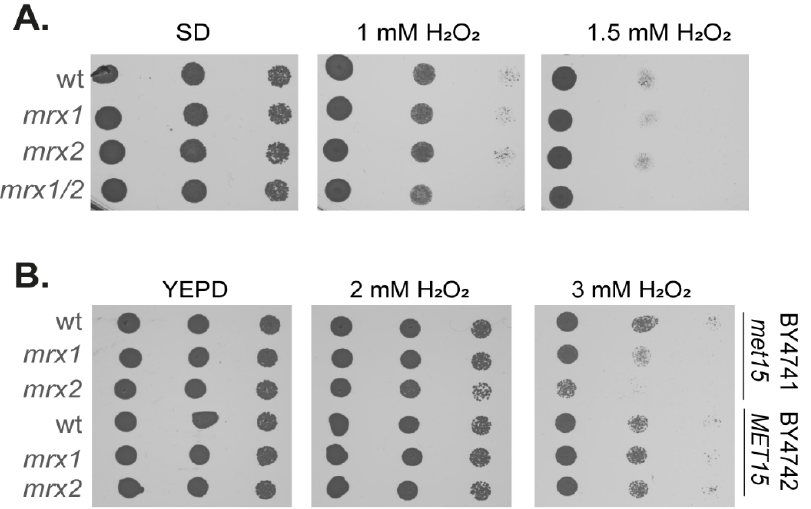
Figure 1. Strains lacking MXRs are unaffected by hydrogen peroxide sensitivity. ( A ) Wild-type (74D-694) and MXR mutant strains were grown to the exponential phase, and the A 600 adjusted to 1, 0.1, 0.01, or 0.001 before spotting onto plates containing the indicated concentrations of hydrogen peroxide. ( B ) Wild-type (BY4741, BY4742) and isogenic MXR mutant strains were tested for hydrogen peroxide sensitivity as described in panel A.